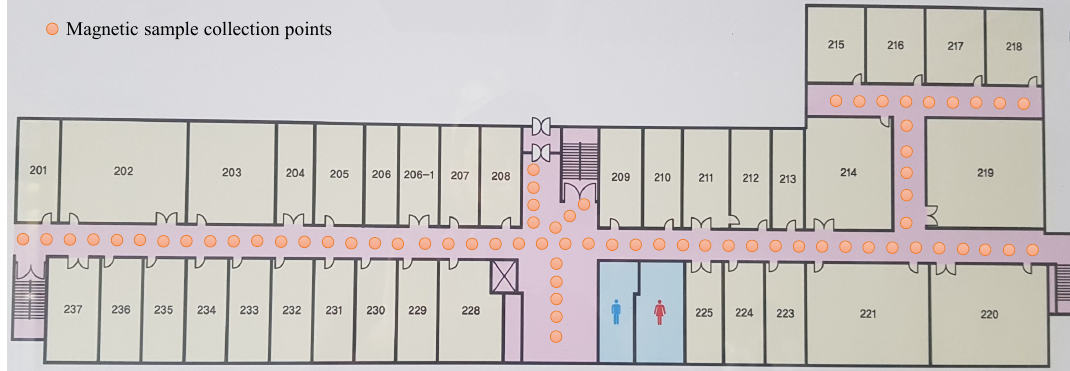
Figure 4. Magnetic fingerprint collection.